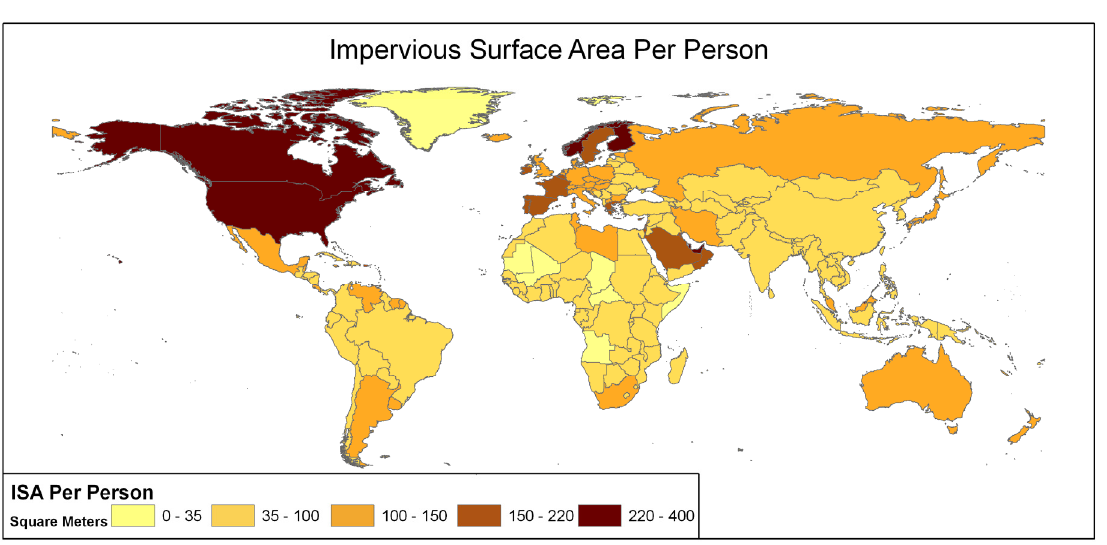
Figure 9. Square meters of constructed impervious surface per person for the countries of the